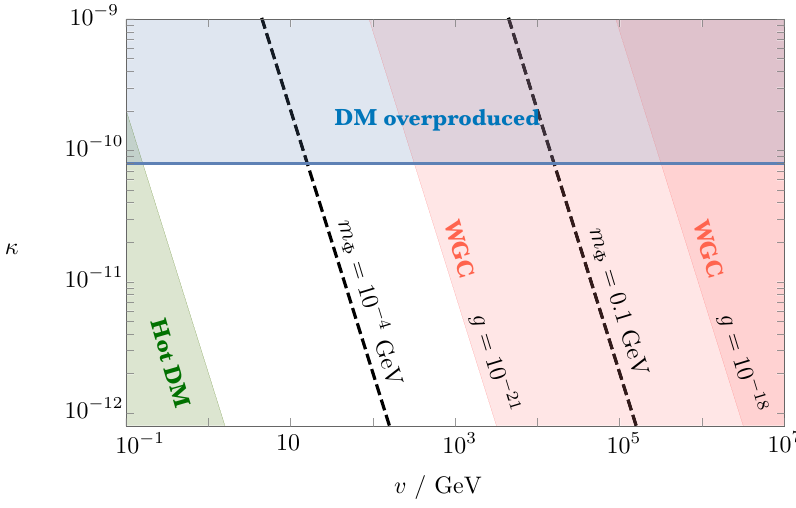
Figure 2 . Everywhere in this plot m κ/ 2 v . The correct DM relic density is obtained through Φ = Higgs portal freeze-in along the horizontal blue line, corresponding to the value of κ in eq. (4.3), (cid:31) with the region above the line corresponding to DM overproduction. The green region corresponds to m Φ (cid:31) 1 keV, and is ruled out as DM would be hot. The pink region corresponds to Φ being sub-extremal for the values of the gauge coupling g indicated in the figure, and therefore is ruled out by the